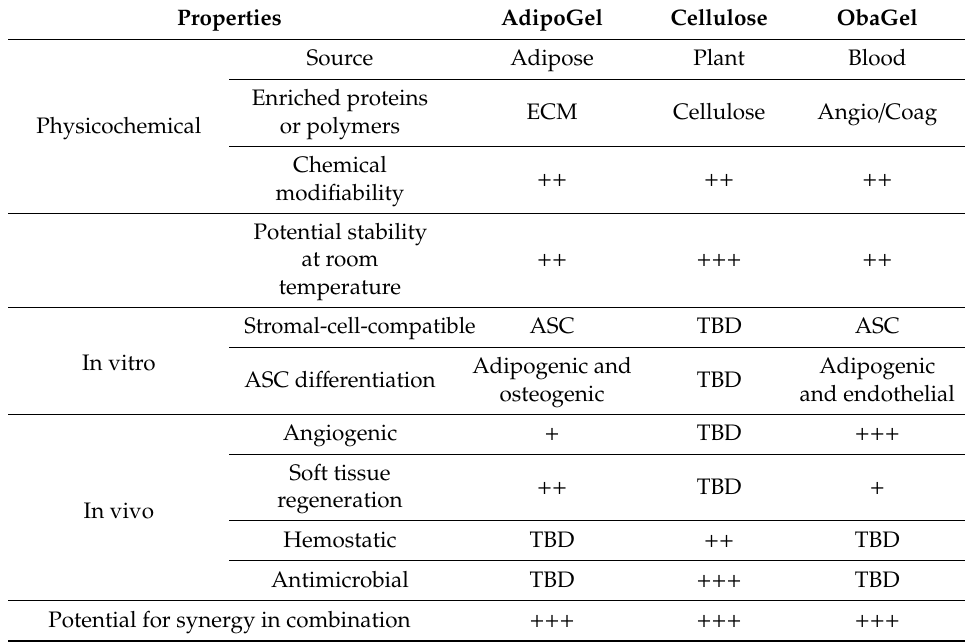
Table 2. Hydrogel summary: physicochemical, in vitro, and in vivo properties. Properties AdipoGel Cellulose ObaGel Source Adipose Plant Blood Enriched proteins ECM Cellulose Angio / Coag Physicochemical or polymers Chemical ++ ++ ++ modifiability Potential stability ++ +++ ++ at room temperature Stromal-cell-compatible ASC TBD ASC In vitro Adipogenic Adipogenic and TBD ASC di ff erentiation and endothelial osteogenic Angiogenic + TBD +++ Soft tissue ++ TBD + regeneration In vivo Hemostatic TBD ++ TBD Antimicrobial TBD +++ TBD Potential for synergy in combination +++ +++